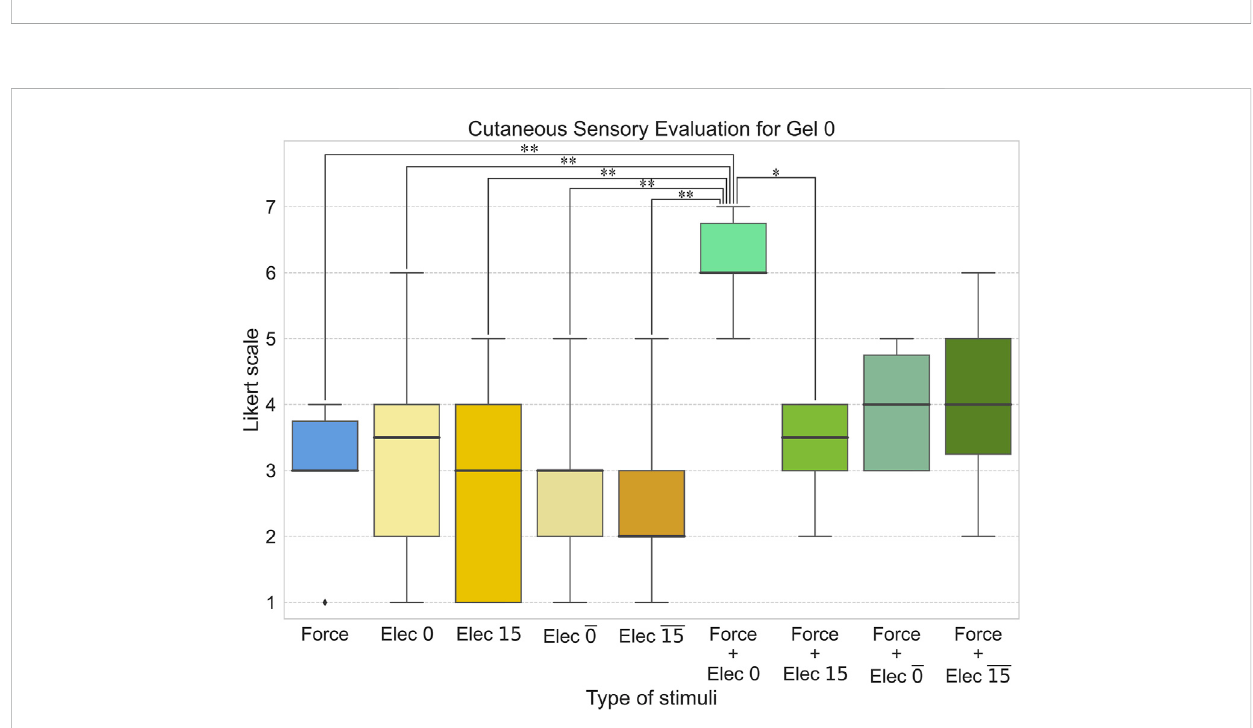
In the subjective evaluation experiment of Experiment 2, the realism of softness was signi fi cantly improved only when force stimuli that reproduced the actual reaction force and electrical stimuli that simulated the actual expansion of the contact area (Elec 0 and Elec 15, respectively) were presented simultaneously